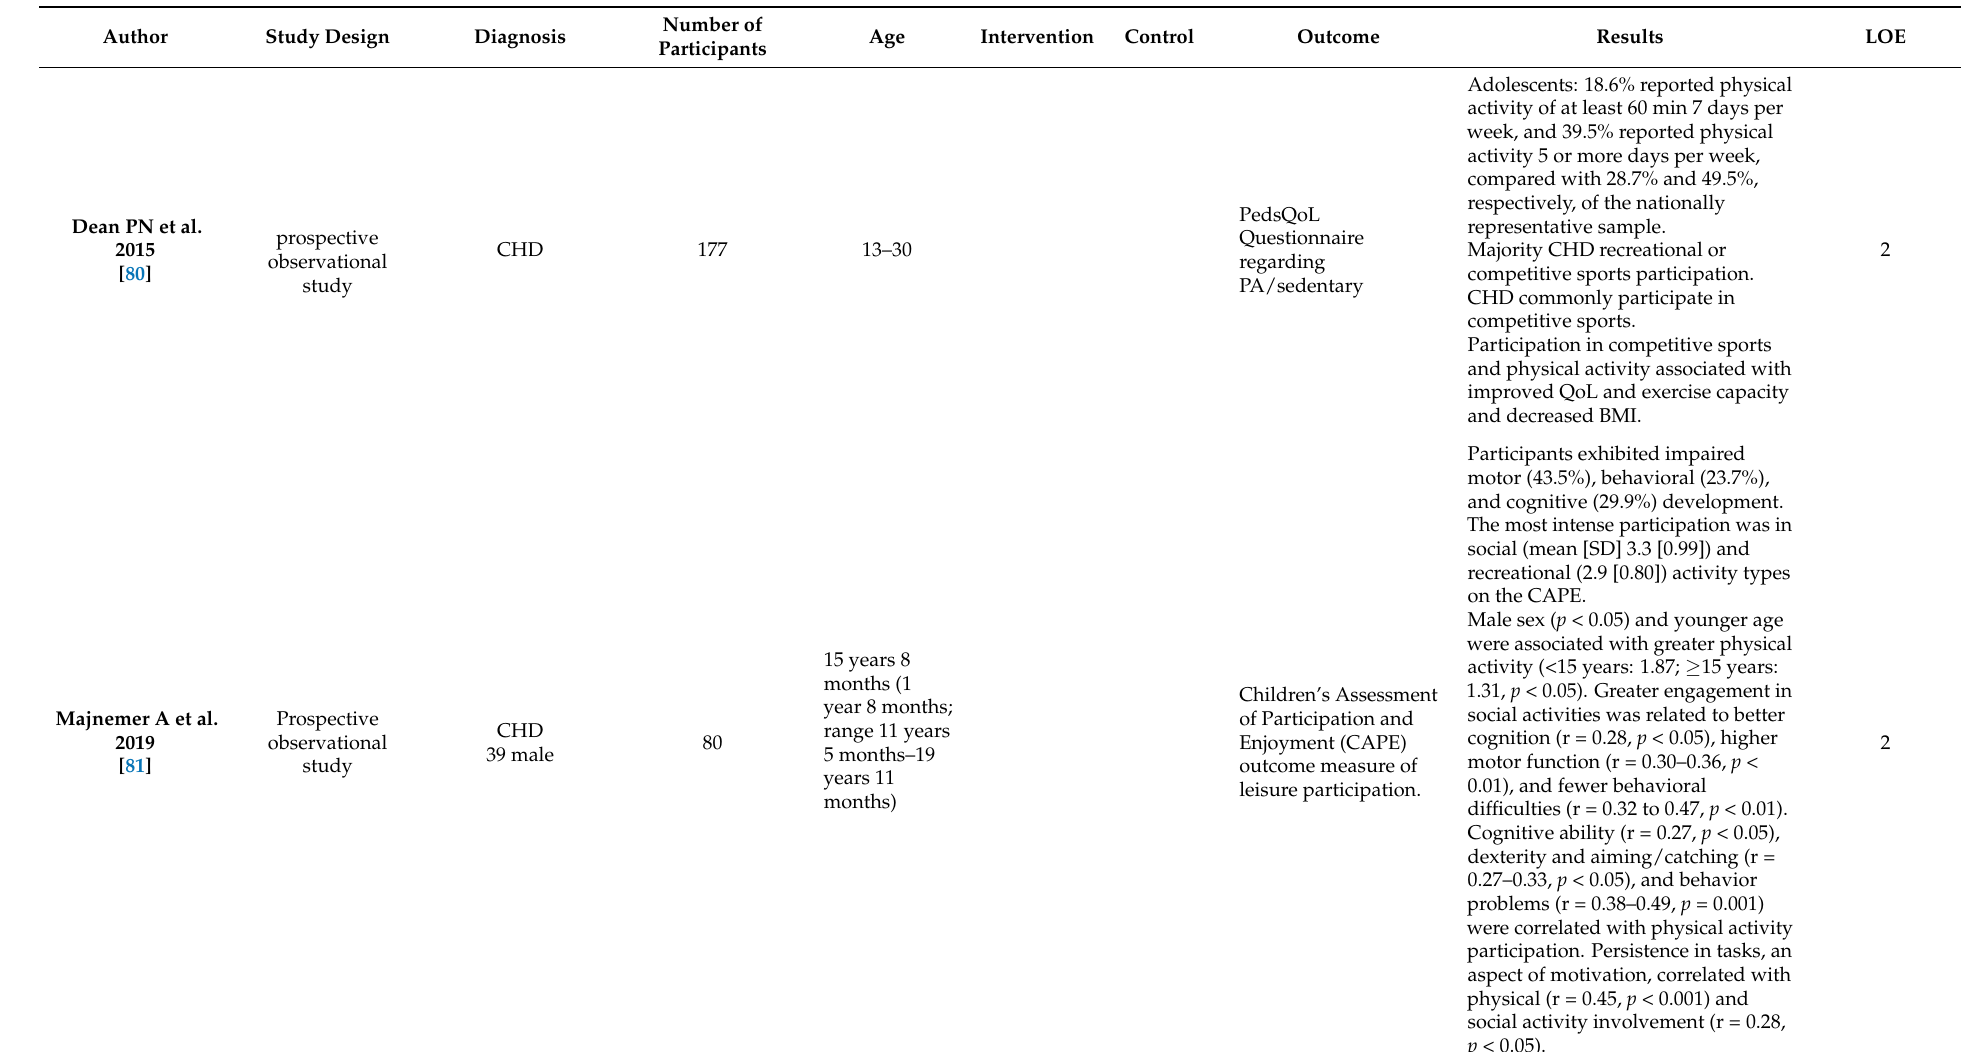
Table 2. Observational studies and